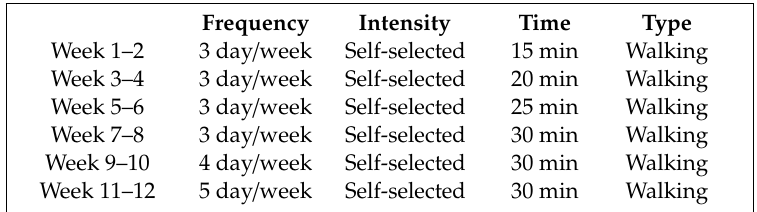
Box 1. Physical activity counseling goals over the 12 weeks of intervention in adults with